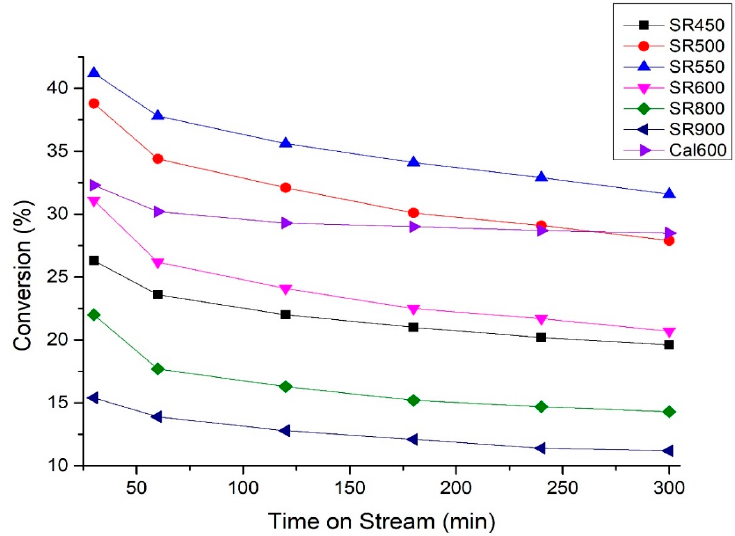
Figure 1. Propane conversion over Pt–Sn/Al 2 O 3 . Reaction conditions: catalyst weight, 0.1 g; reaction temperature, 600 ◦ C; and flow rate, H 2 :C 3 H 8 = 32:32 (mL / min).